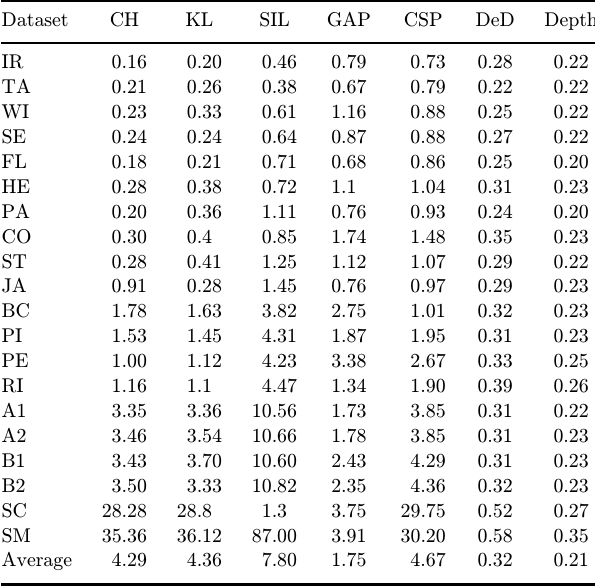
Table 4. Time, in seconds of 10 runs.